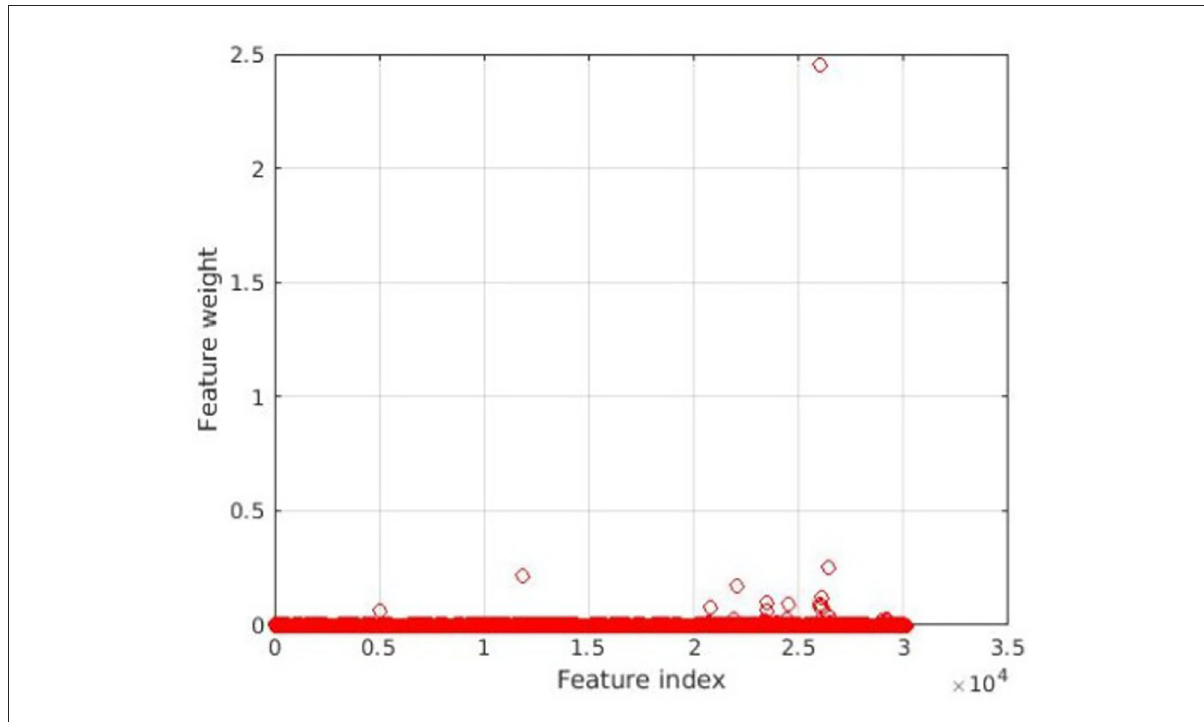
FIGURE1 Feature selection through neighborhood component